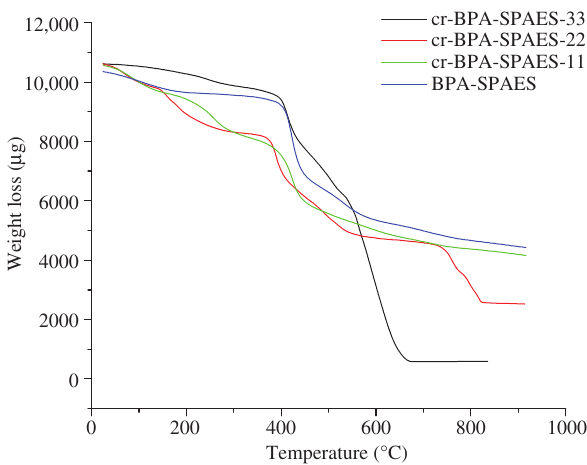
Figure 9: TGA graphs of BPA-SPAES and its crosslinked cr-BPA- SPAES membranes.